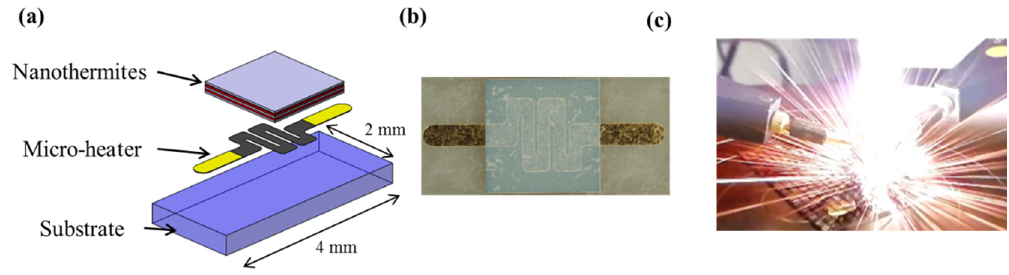
Figure 3. ( a ) 3D schematic representation of a pyroMEMS; ( b ) photo of the pyroMEMS; ( c ) photo during the nanothermite reaction.